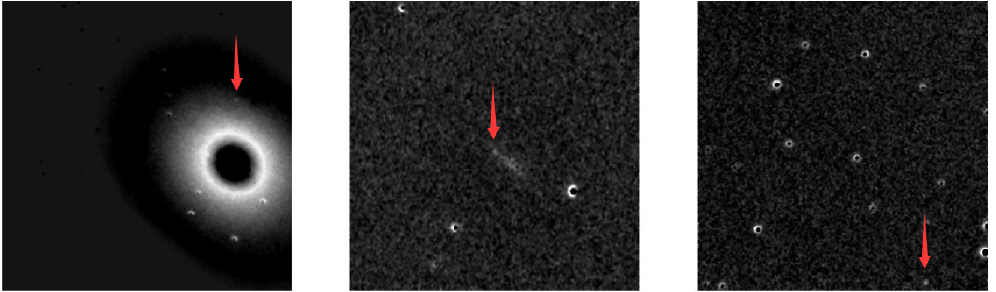
Figure 8. The dim targets cause false negative predictions. Red arrow points to the dim supernova in the